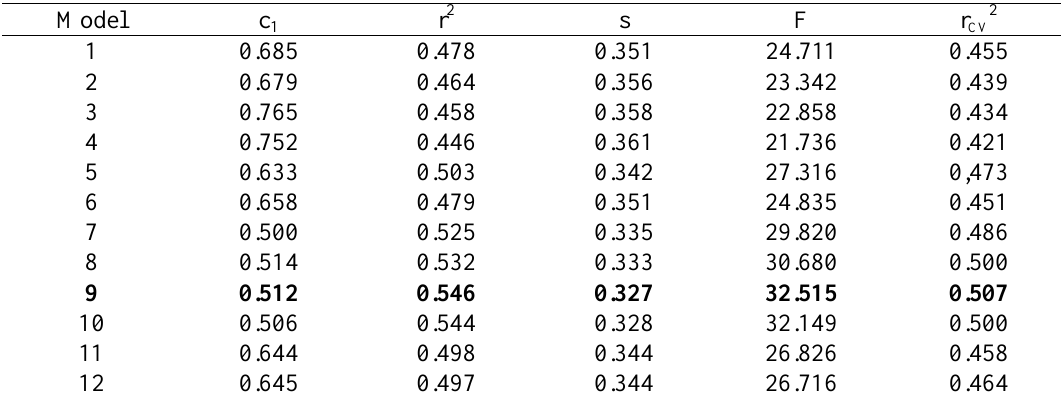
Table 3. Statistics of the various SOMFA